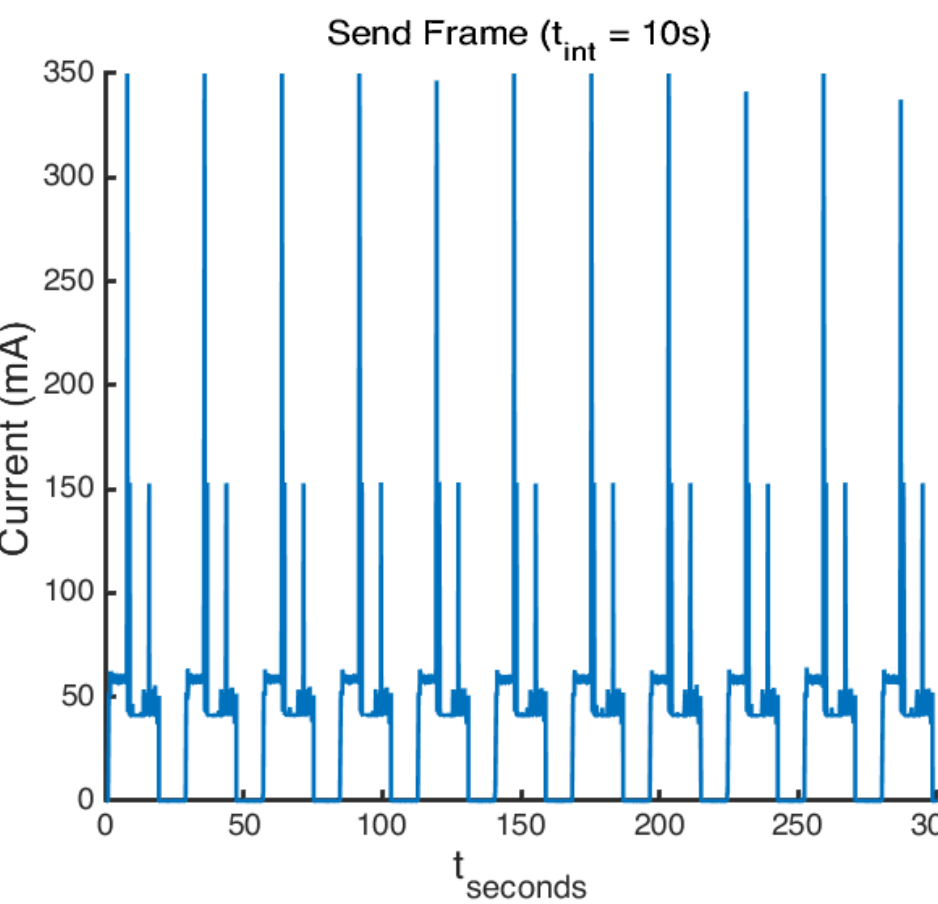
Figure 5. Current consumption over time showing frame transmission peaks. Deep sleep mode enabled between transmissions with a sleep duration ( t int ) of 10